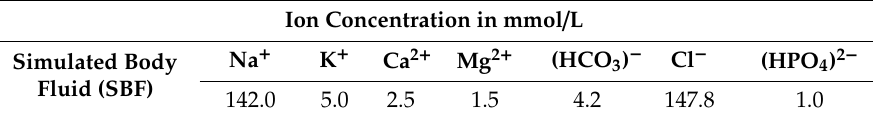
Figure 4. Overview of the sample preparation. Table 3. Ion concentration of the used simulated body fluid according to [35] .